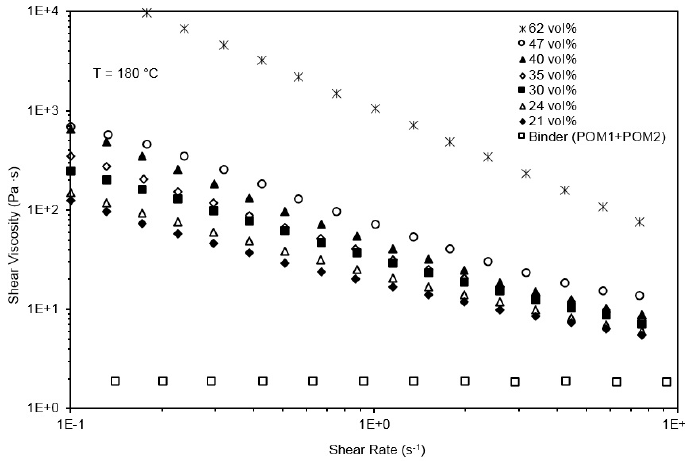
Figure 5. Viscosity of POM ‐ based feedstock materials with different powder content.